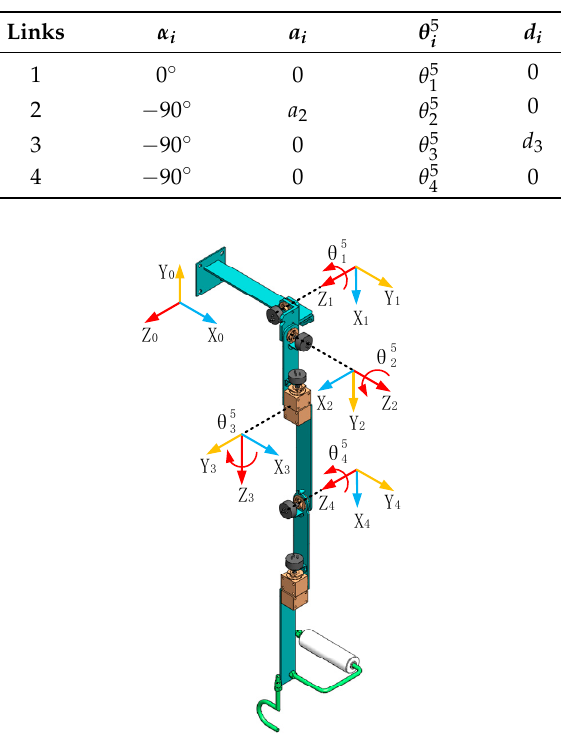
Figure 6. Kinematic configuration and coordinate of the 5 ‐ DOF upper ‐ limb exoskeleton.